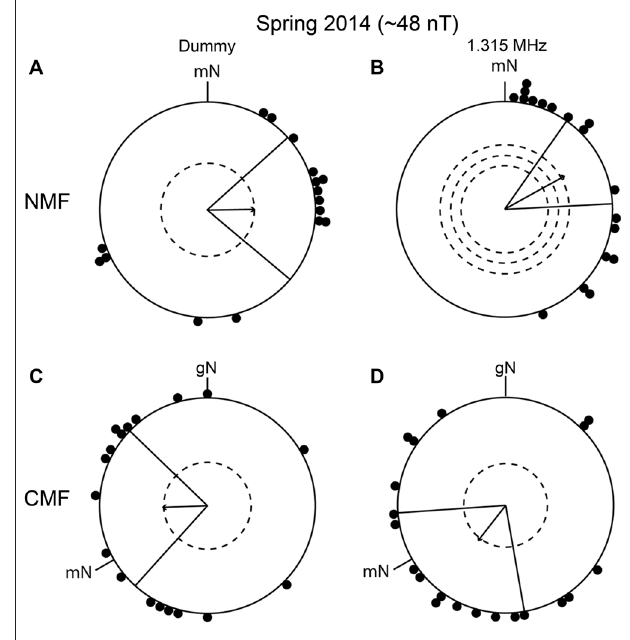
FIGURE 7 | Replication of the experiments from autumn 2013. (A,C) The birds’ orientation under the dummy condition in spring 2014. (B,D) The orientation of the birds during exposure to 1.315 MHz in spring 2014. The data in (A,B) were collected in an unchanged magnetic field (NMF, dummy: mean direction 89 ◦ ± 41 ◦ , r = 0.44, p < 0.05, N = 16; 1.315 MHz: mean direction 61 ◦ ± 26 ◦ , r = 0.64, p < 0.001, N = 18). The data in (C,D) were collected in a magnetic field turned 120 ◦ counterclockwise (CMF, dummy: mean direction 268 ◦ ± 46 ◦ , r = 0.42, p < 0.05, N = 18; 1.315 MHz: mean direction 218 ◦ ± 48 ◦ , r = 0.42, p < 0.05, N = 20). For a description of the circular diagrams, see the legend to Figure 5